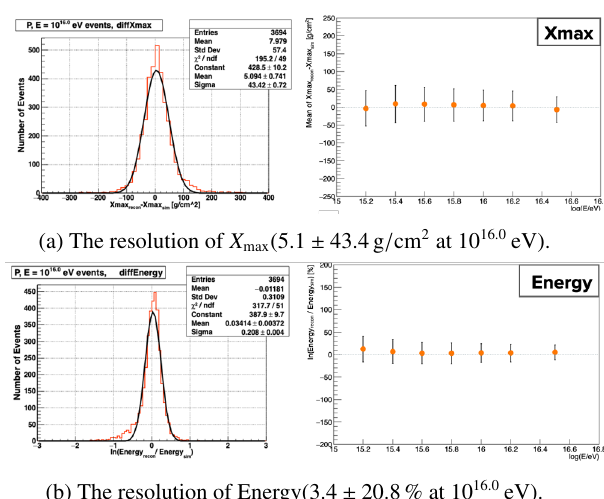
Figure 6: The resolution of parameter. The plots and error bars on the right are the mean and sigma obtained by fig- ging the histogram on the left with the Gaussian function.